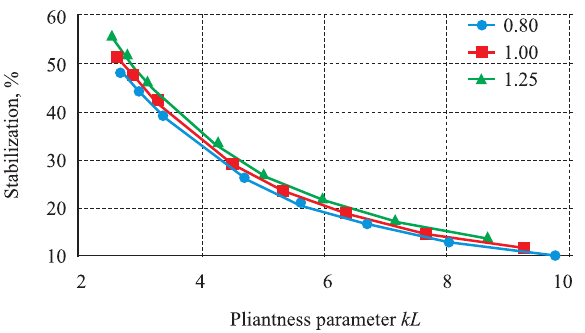
Fig. 5. Stabilization of standing pier horizontal displacements, by the bending